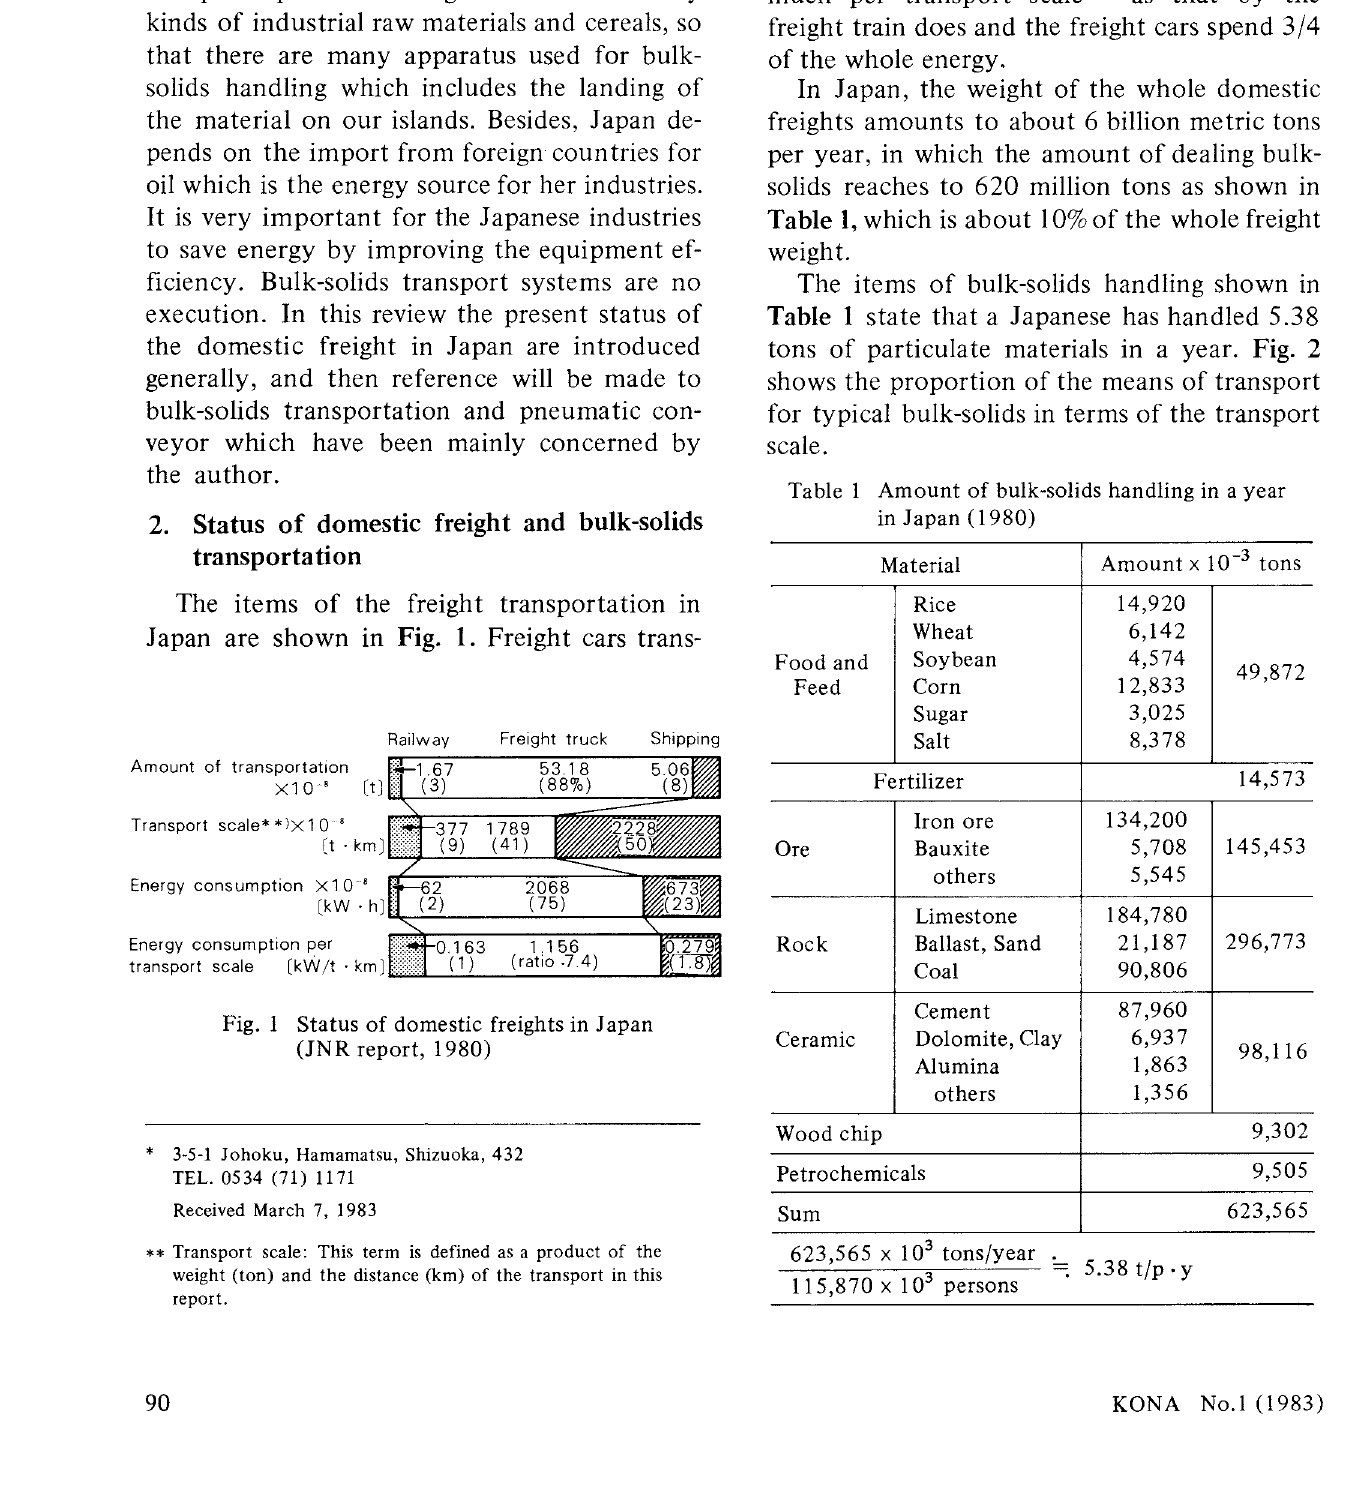
Fig. I Status of domestic freights in Japan (JN R report, 19